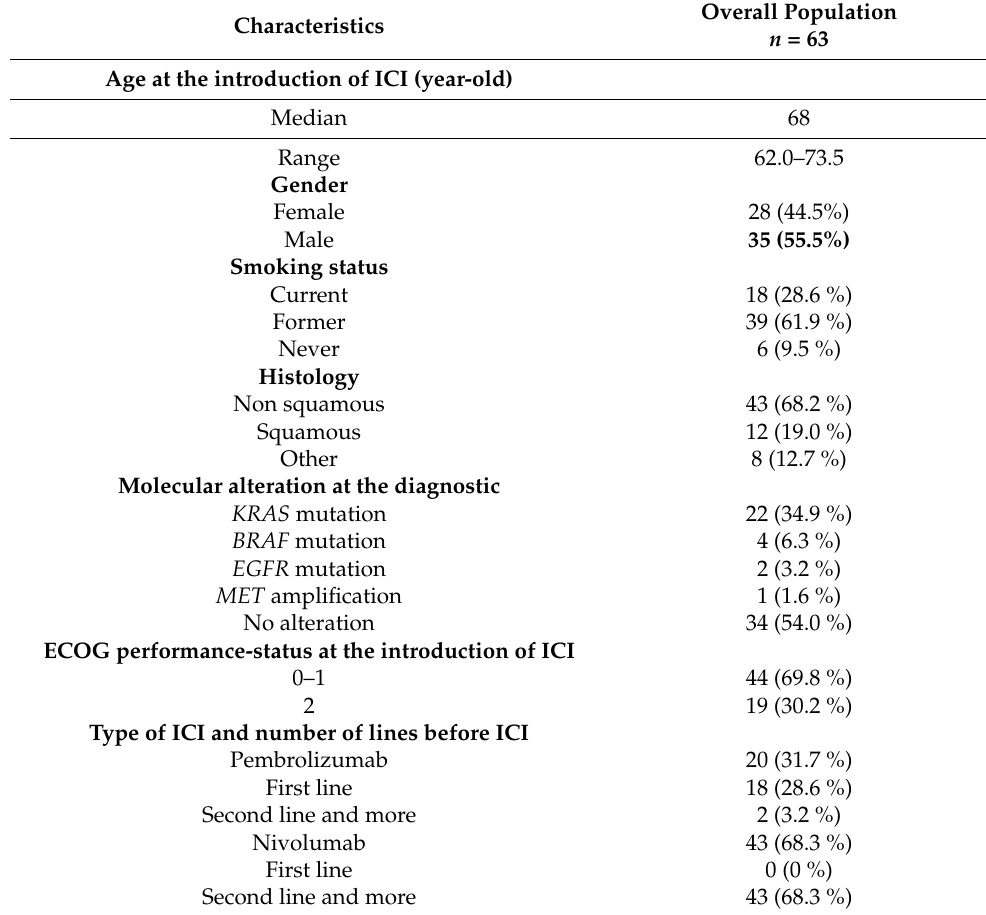
Table 1. Characteristics of the